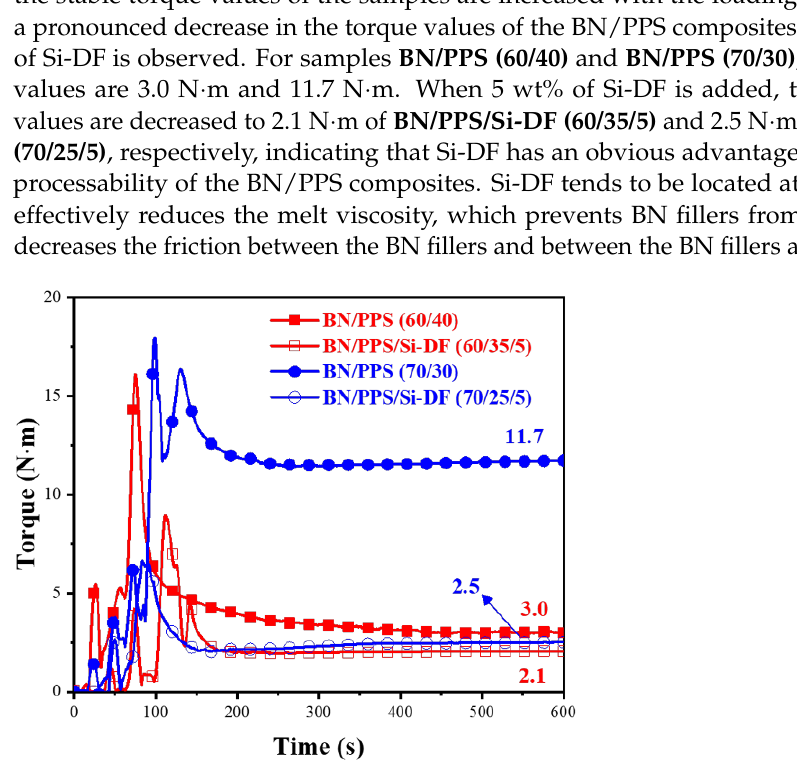
Figure 6. Dielectric constant-frequency curves of PPS matrix and BN/PPS composites.